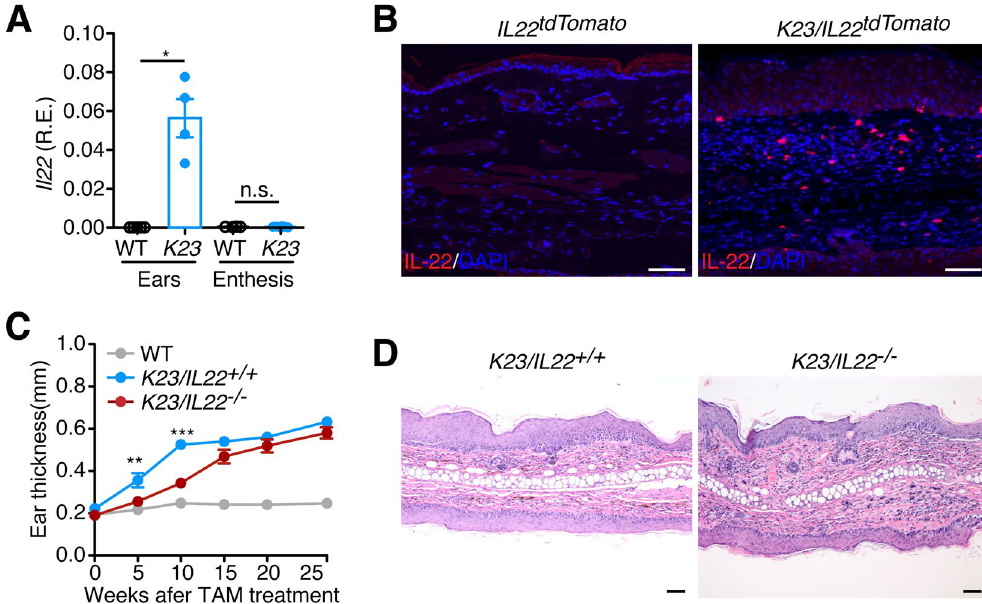
Figure 7. IL-22 is not required for development of skin inflammation. ( A ) Relative expression of IL-22 mRNA in the ears and enthesis of WT and K23 mice 20 weeks after TAM treatment (n = 4-5 mice/group). Data are shown as mean ± SEM, ns, p > 0.05, * p < 0.05, by nonparametric Mann-Whitney test. ( B ) Immunostaining of the ears of IL22 tdTomato and K23/IL22 tdTomato mice 20 weeks after TAM treatment were stained with anti-tomato antibody. Cell nuclei were counterstained with DAPI (blue). Notice the accumulation of IL-22 positive cells in the ears of K23 mice compared to WT mice. n = 5 per group. ( C ) Quantification of the ear thickness of WT, K23/IL22 + / + , and K23/IL22 − / − mice after TAM treatment (n = 20–30 mice/time point). Data are shown as mean ± SEM, ** p < 0.01, *** p < 0.001 compared with WT mice at the same time point by nonparametric Mann-Whitney test. ( D ) Representative H&E sections of K23/IL22 + / + mice and K23/IL22 − / − mice ears 20 weeks after TAM treatment. Scale bars, 50 μ